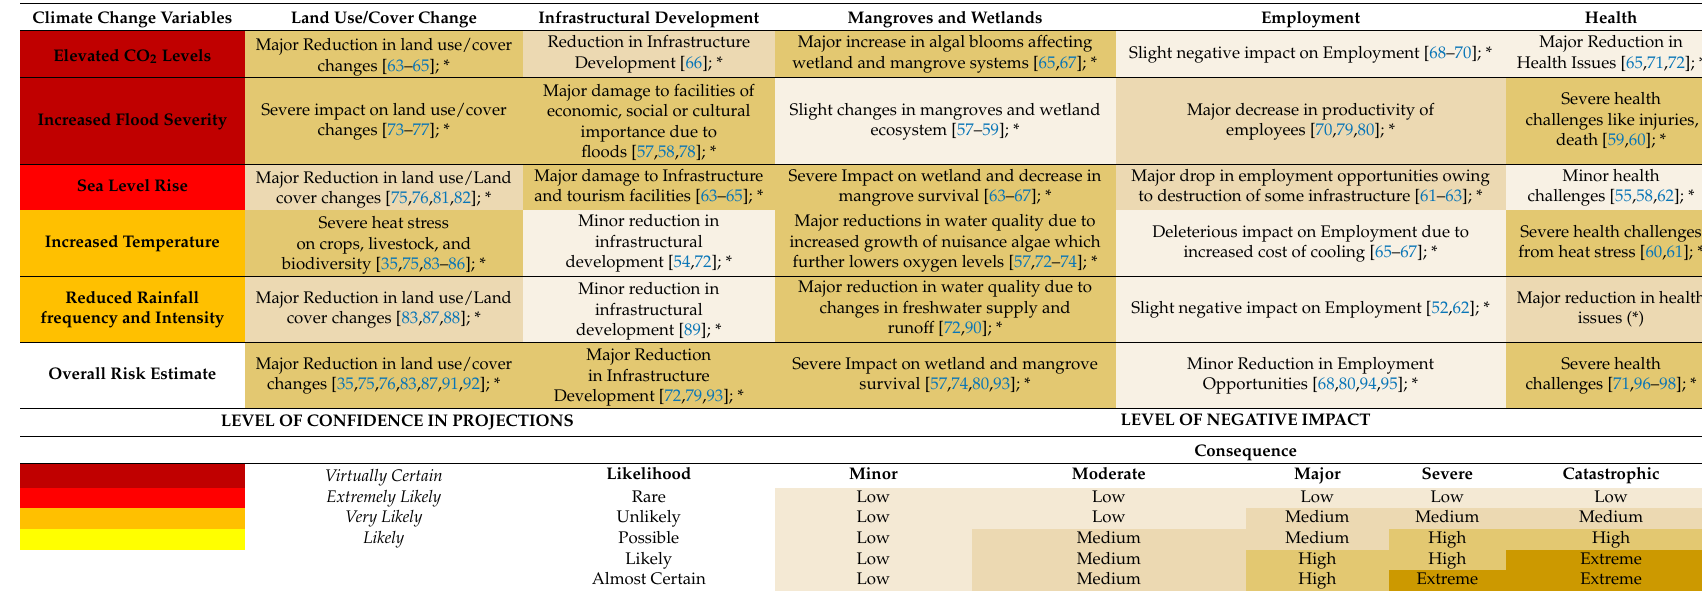
Table 7. Impact Risk Matrix describing the impacts of the key elements of the coastal zone of The Gambia to climate